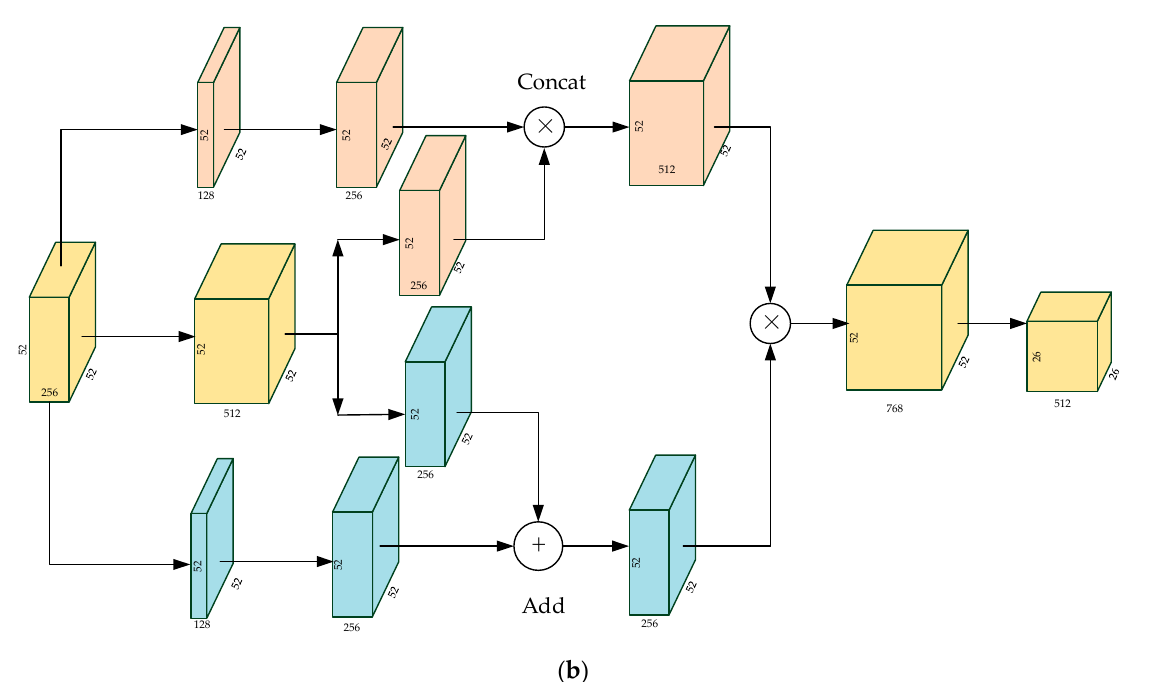
Figure 8. The structures of Dual Path Feature Enhancement Modules (DPFE). ( a ) DPFE 1. ( b ) DPFE 2.